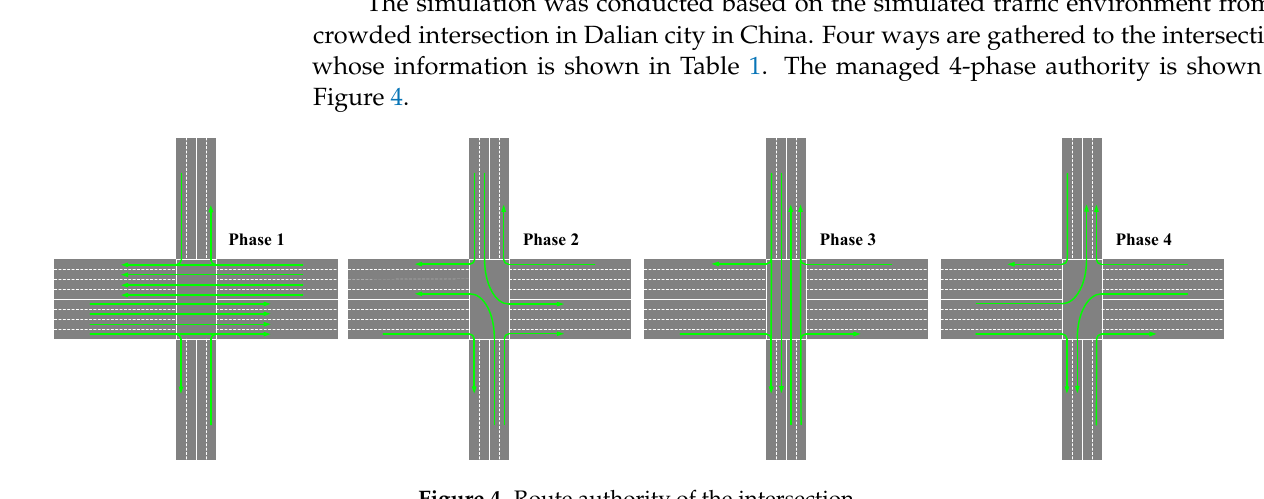
Table 1. Information of intersection.